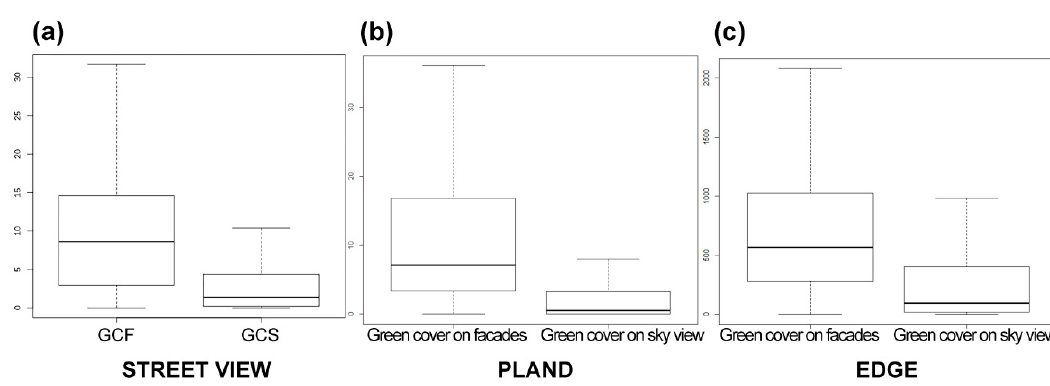
Figure 7. Frequency distribution metrics: ( a ) street view metrics ( b ) percentage of landscape (PLAND) and ( c ) edge density (EDGE).